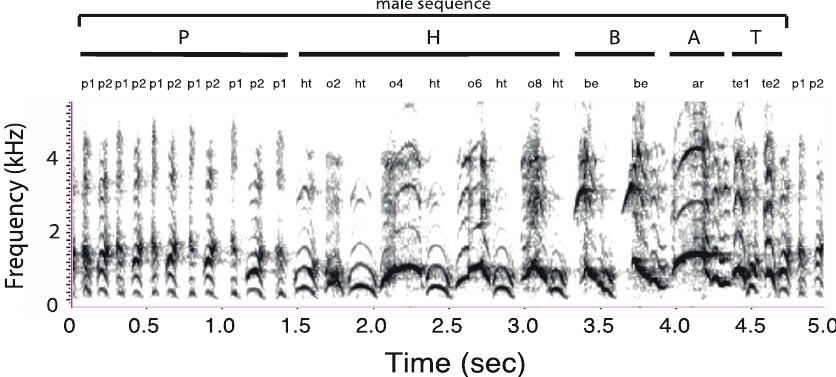
Figure 3. Hierarchical organization of a male Plecturocebus donacophilus solo song. The spectrogram shows a sequence composed of five song phrases depicted by horizontal bars. Each phrase consists of consecutive paired syllables, exhibiting some variation in syllable structure (o2, o4, o6, and o8). Individual syllables have been labeled with small letters and numbers. P: pant phrase; H: hoot phrase; B: bellow phrase; A: arch phrase; T: terminal phrase.